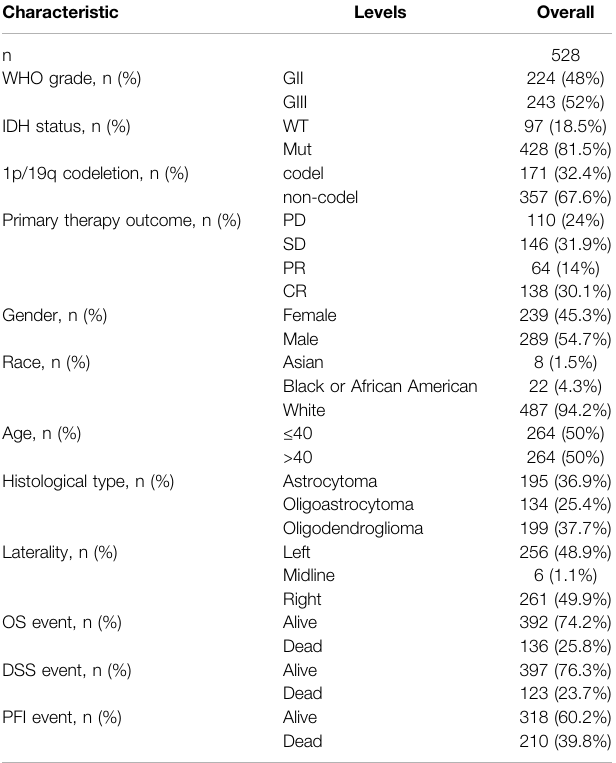
TABLE 1 | Characteristics of patients with gliomas based on TCGA.